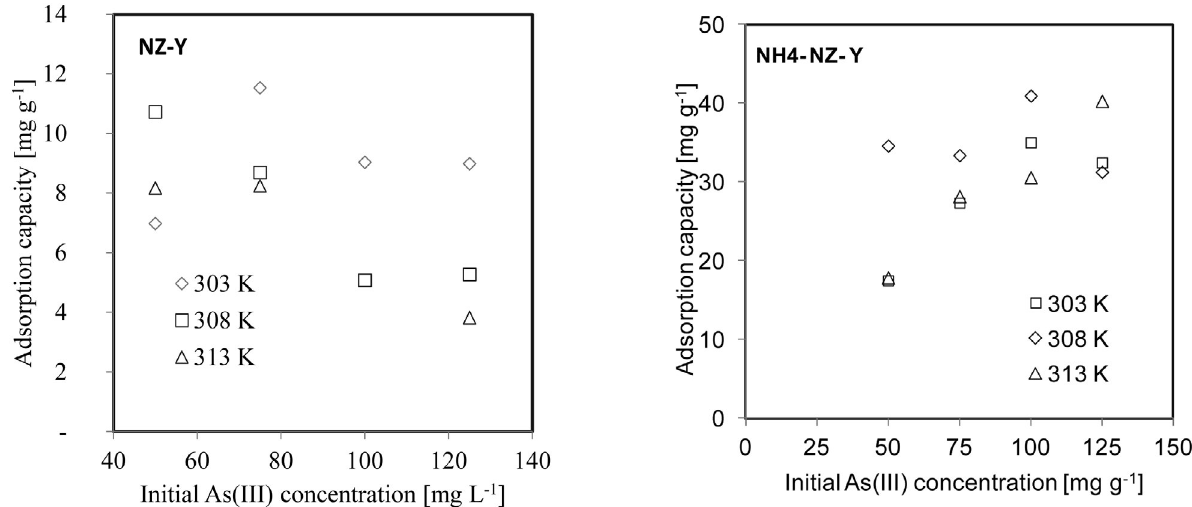
Figure 7. Adsorption capacity of NZ-Y and NH4-NZ-Y for removal of As(III) at different temperatures as a function of initial As(III)